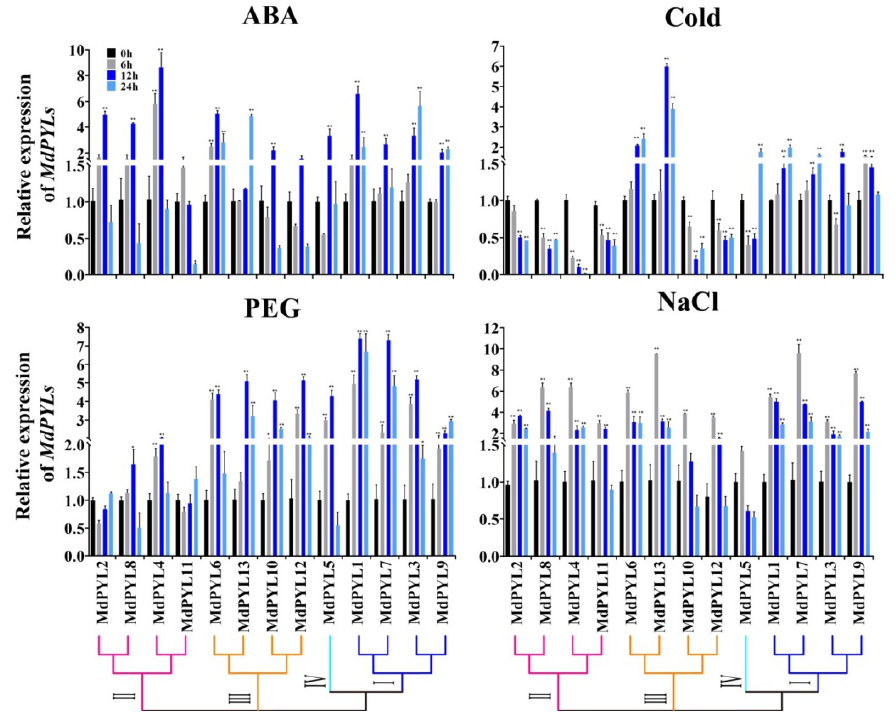
Figure 9. Expression of the apple MdPYLs under ABA, PEG, cold (4 °C), and salt treatment in the tissue-cultured apple seedlings (Xinjiang No.1). The gene relative expression was calculated using the 2- ∆∆ Ct method with MdActin as an internal control, and value represents mean ± SD of three biological replicates. Asterisks indicated values that are significantly di ff erent from CK (0 h) (* p < 0.05, ** p < 0.01, one-way